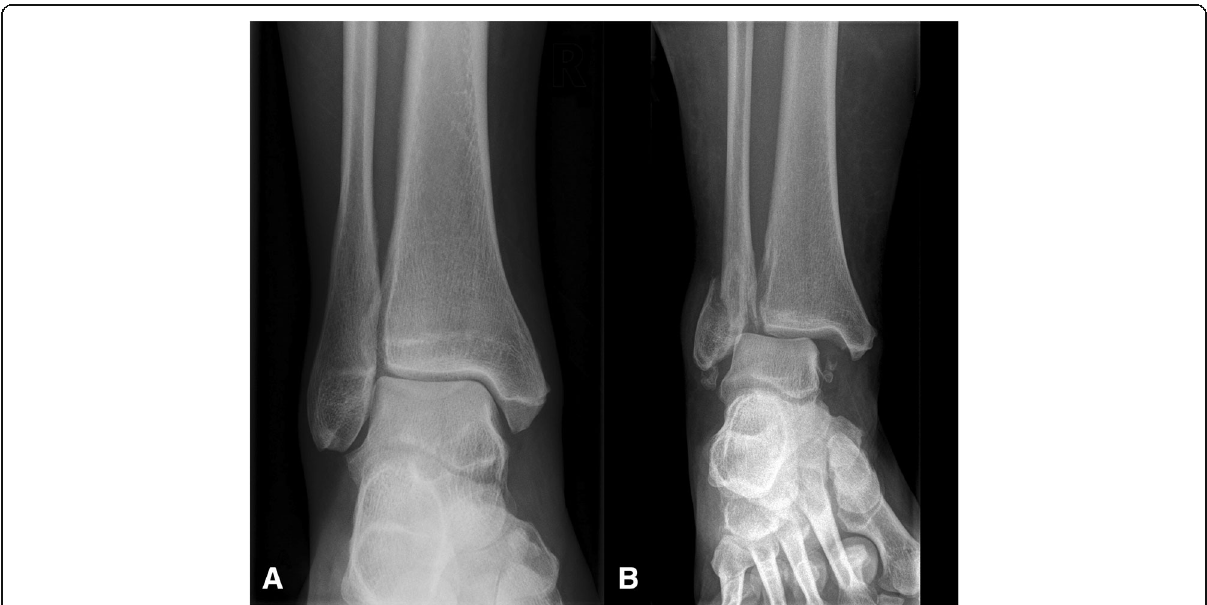
Fig. 1 Examples of radiographs used in the study ( a no fracture, b fracture present)